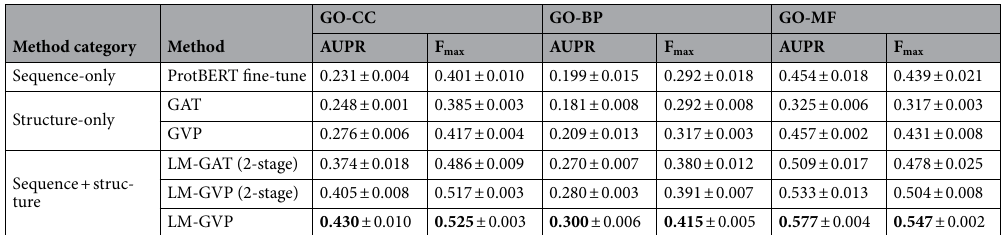
Table 1. Performance of LM-GVP and other baseline models in predicting protein functions in GO hierarches. Function-centric and AUPR and protein-centric Fmax scores from hold-out test sets are shown in the table to evaluate the predictive performances. Averages and standard deviations are estimated over 3 repeated training runs with different random seeds. GAT graph attention network, GVP geometric vector perceptron network. The top performing model is shown in